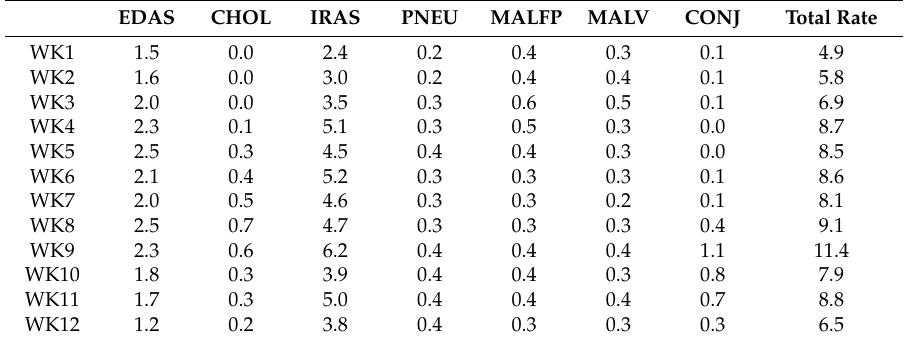
Table A1. Disease incidence rates (per 1000 population) by week.